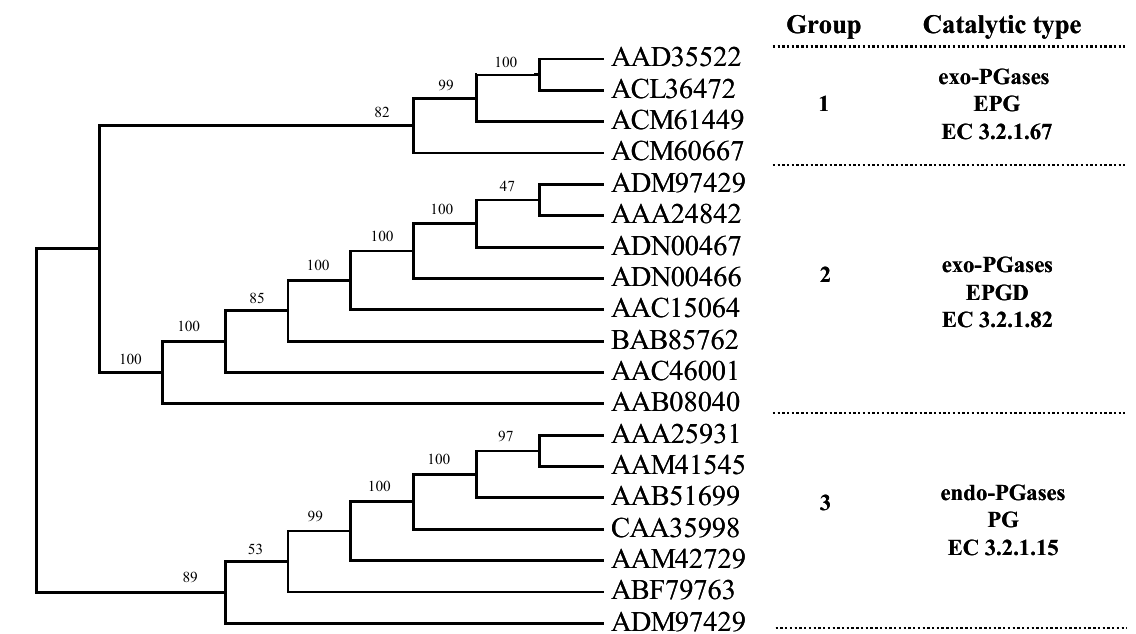
Figure 1. Phylogenetic tree representing a hypothesis of evolutionary relationships for bacterial polygalacturonases (Labels at tree terminals indicate GenBank accession numbers). The confidence scores (percent) of a bootstrap test of 1000 replicates are indicated for major branching